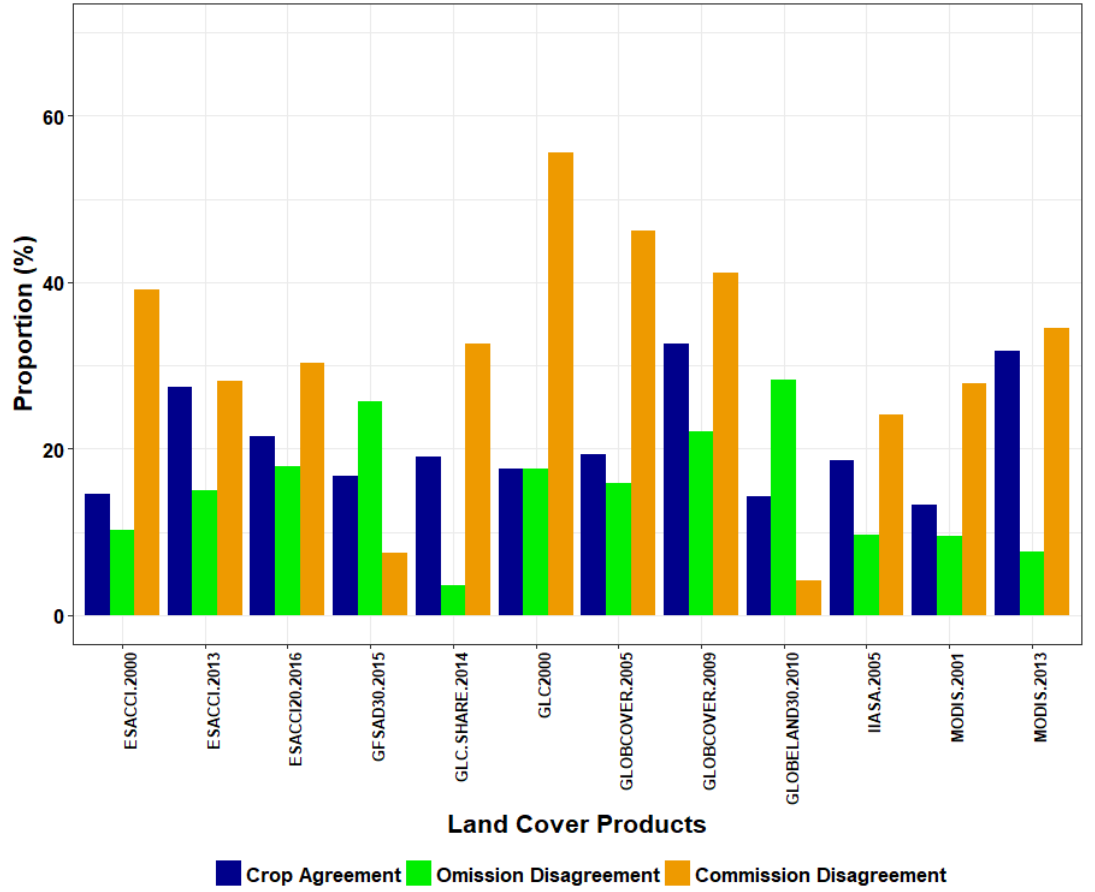
Figure 7. Crop proportion correct with the relative omission and commission misclassifications. Higher commission to omission disagreement = overestimation of cropland, while higher omission to commission disagreement = underestimation of